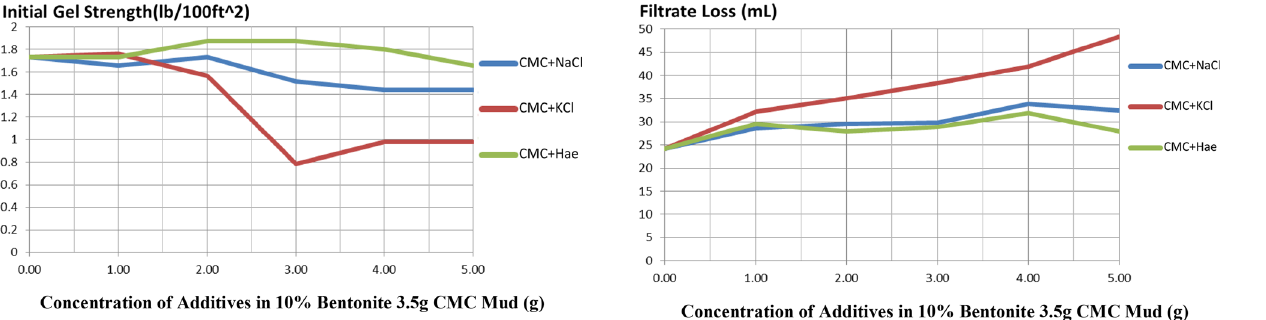
Fig. 10 Effect of NaCl, KCl and haematite on filtrate loss of CMC–